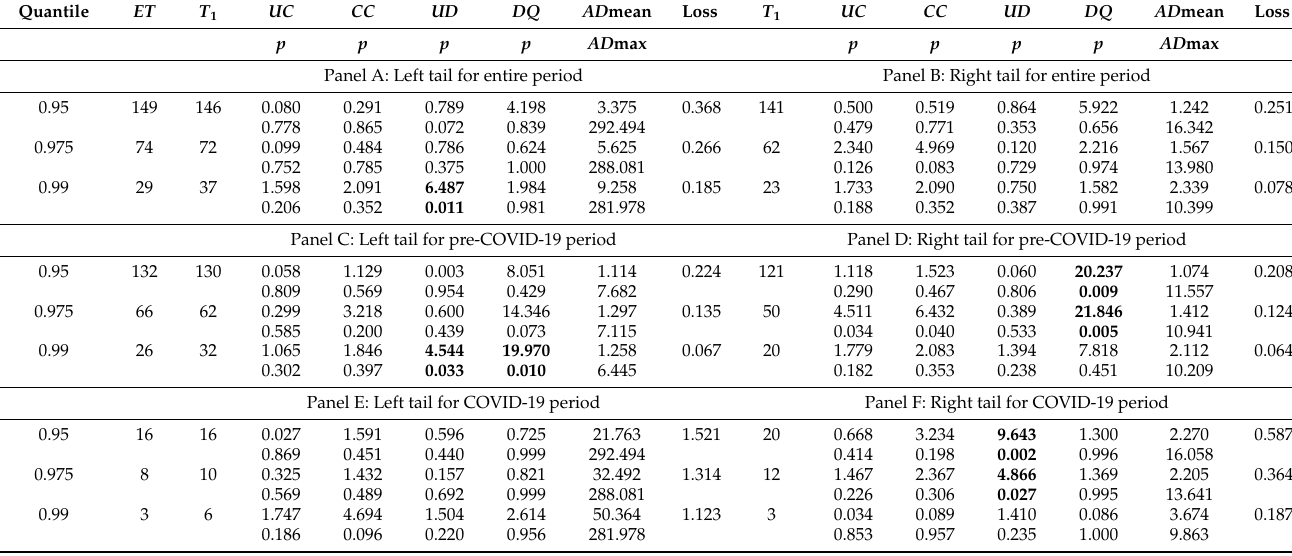
Table 7. Backtesting for VaRs based on the GARCH-EVT with implied volatility.